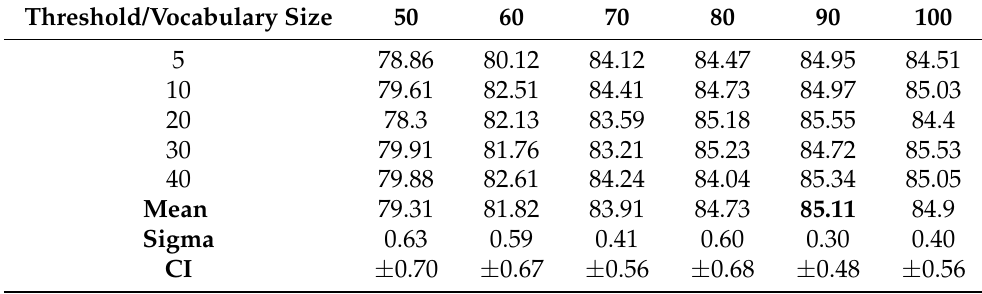
Table 8. Precision metric obtained with 10 queries using SIFT and FLANN varying the matcher threshold and the vocabulary size from 5 to 40 and from 50 to 100, respectively. The sigma and CI rows represent the deviation and Confidence Interval for each